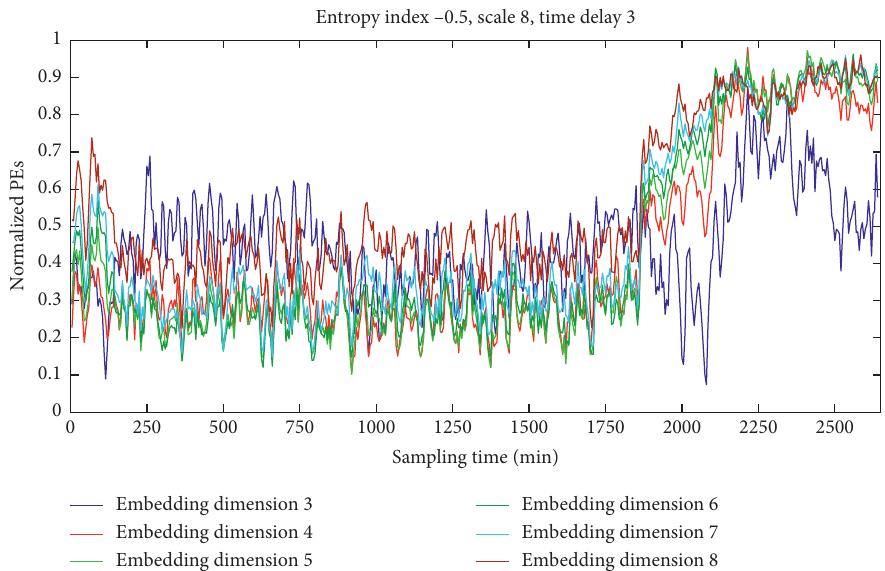
Figure 13: Results of health indicators on different embedding dimensions m .